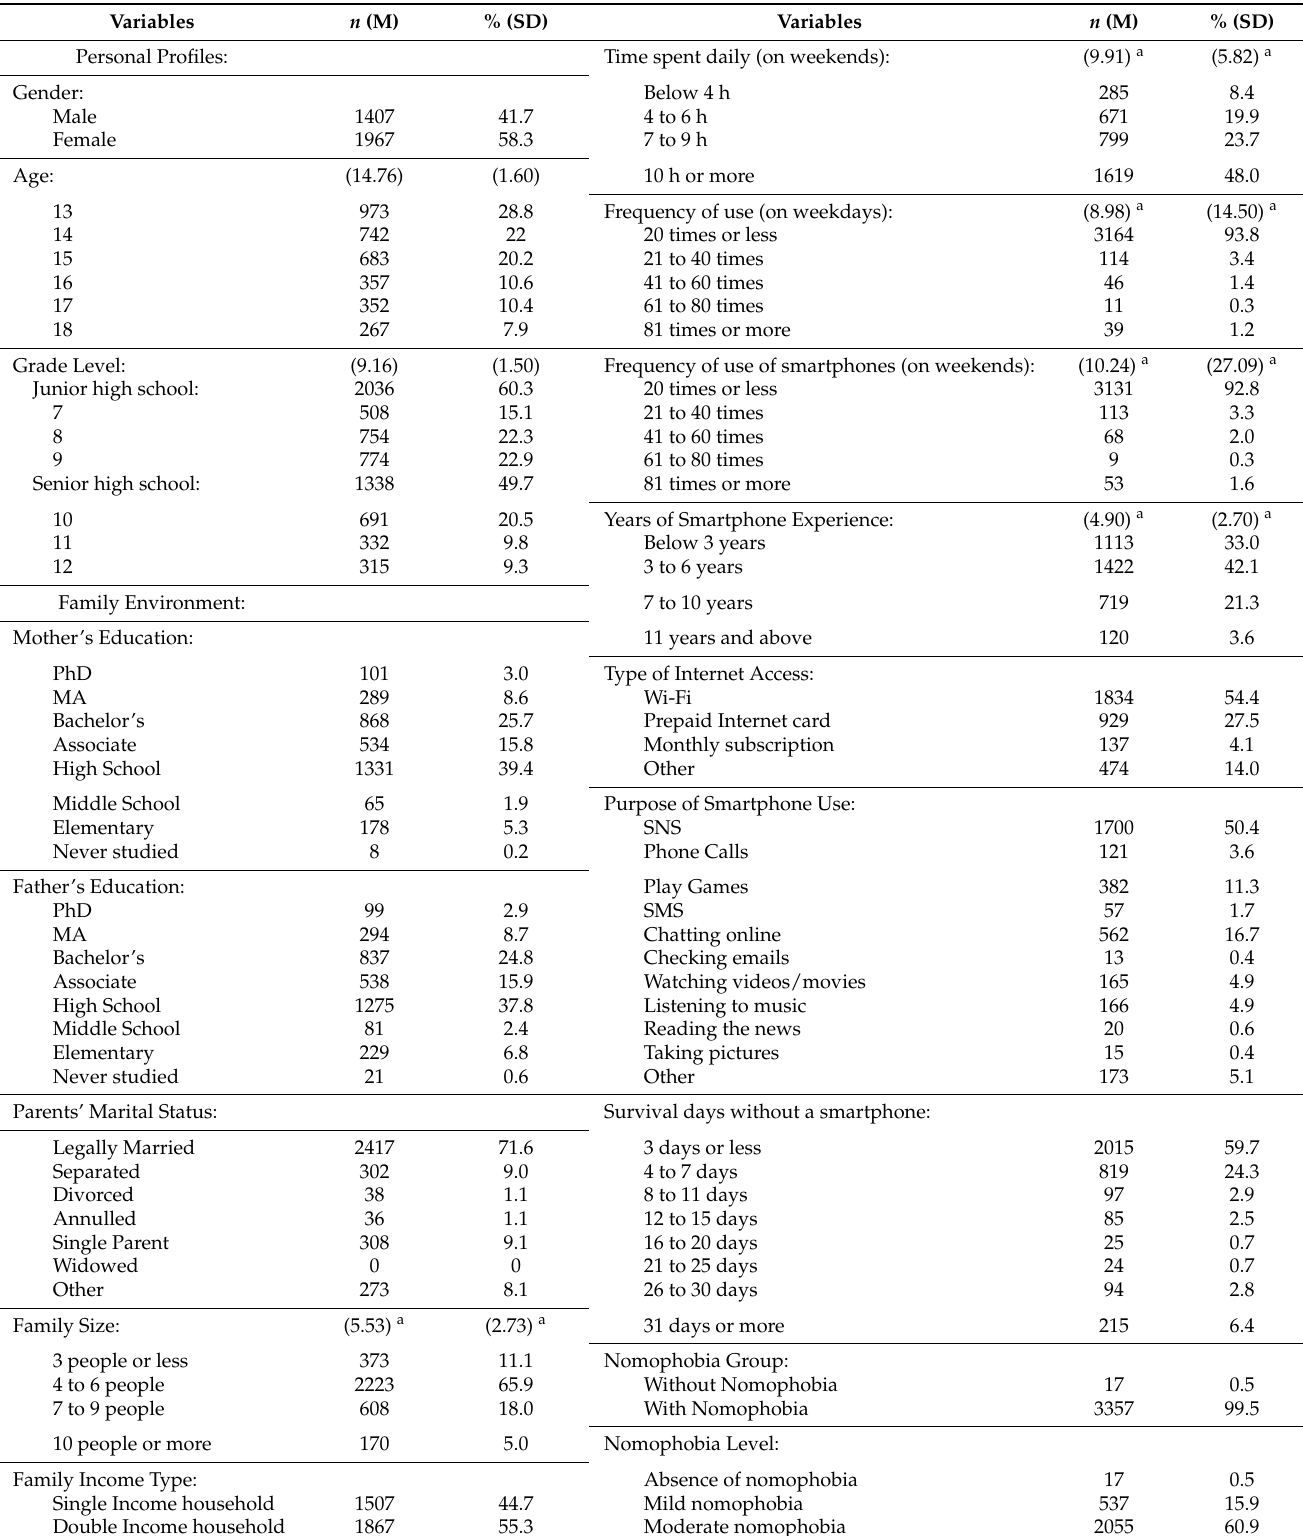
Table 1. Frequency, percentage, mean, and standard deviation among